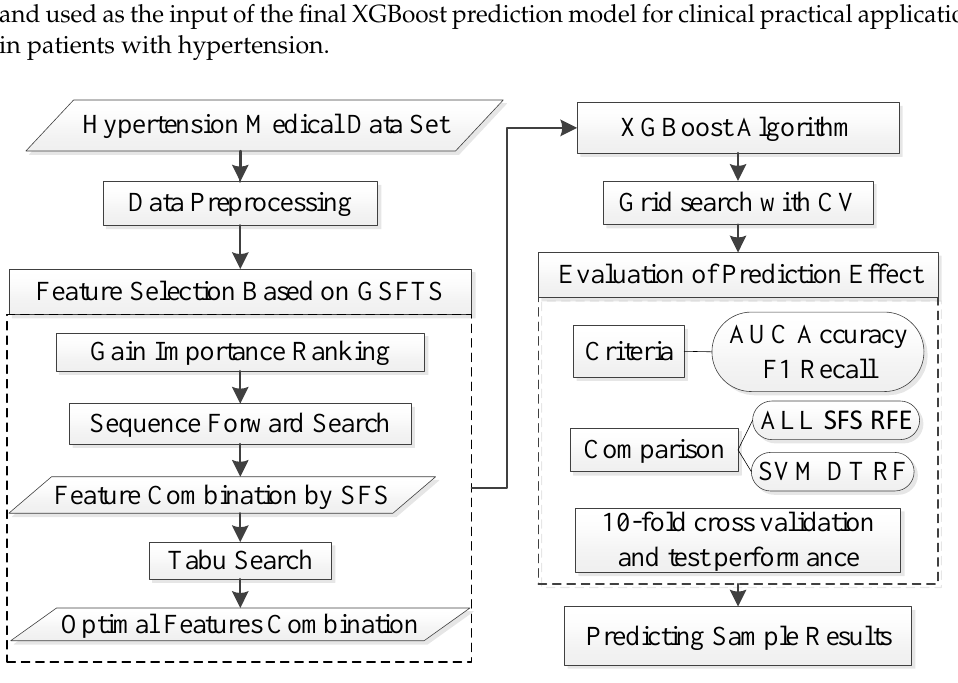
Figure 7. Outcome prediction model for hypertension patients.